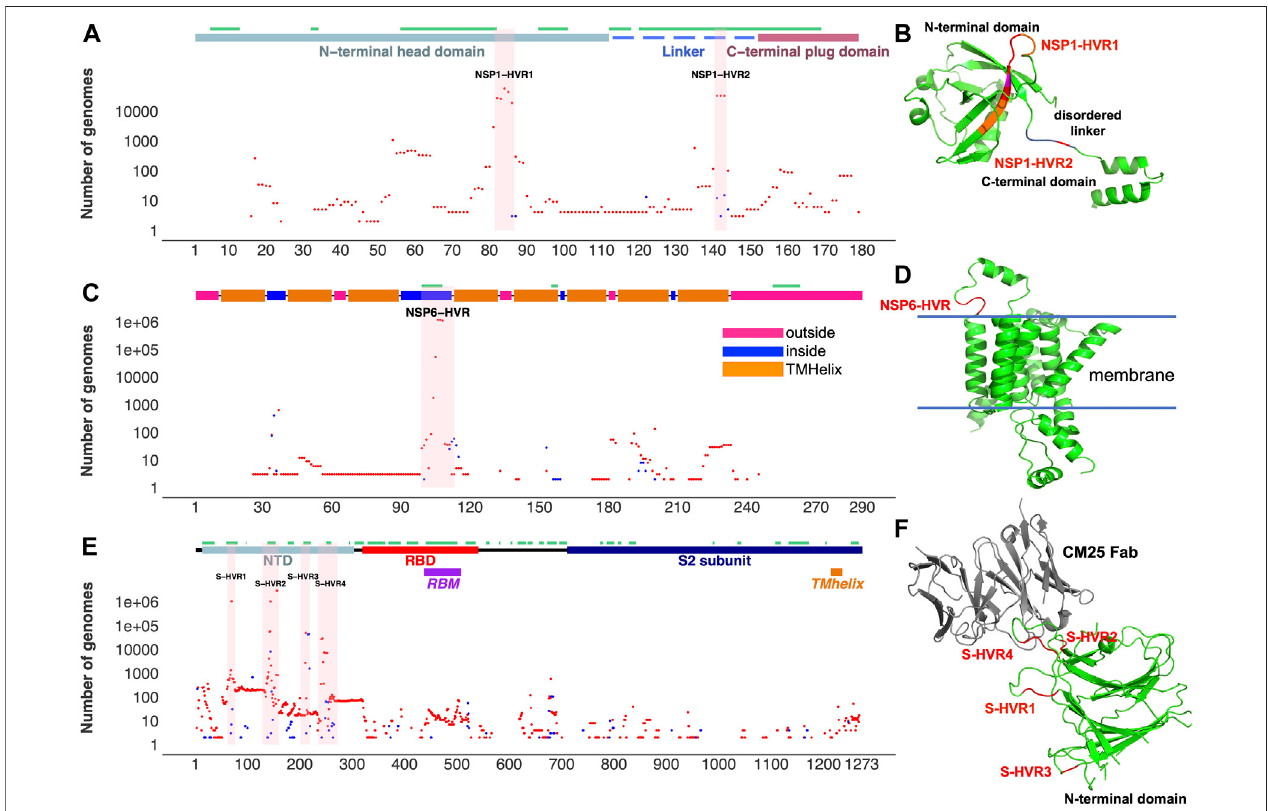
FIGURE 2 | Top SARS-CoV-2 HVRs in the context of protein 3D structures. (A) Distribution of indels in NSP1 (B) NSP1-HVRs on protein 3D structure (C) Distribution of indels in NSP6 (D) NSP6-HVR on protein 3D structure (E) Distribution of indels in spike glycoprotein (F) HVRs on the protein 3D structure of the spike glycoprotein N-terminal domain bound to human Fab CM25. Insertions, deletions, and predicted B-cell epitopes (result from the IEDB server at www.iedb.org) are represented as blue dots, red dots, and green lines, respectively. Supplementary Table S3 provides details of structures/models used in the